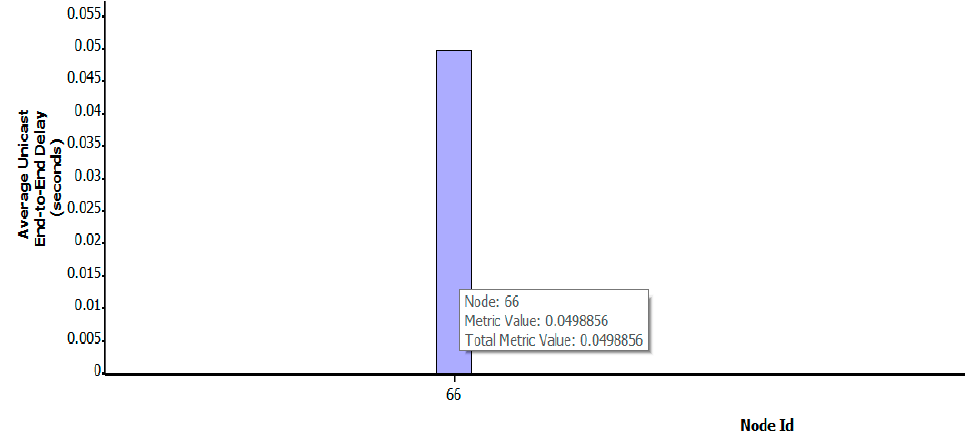
Figure 7. Four–satellite–key–node attack scenario.